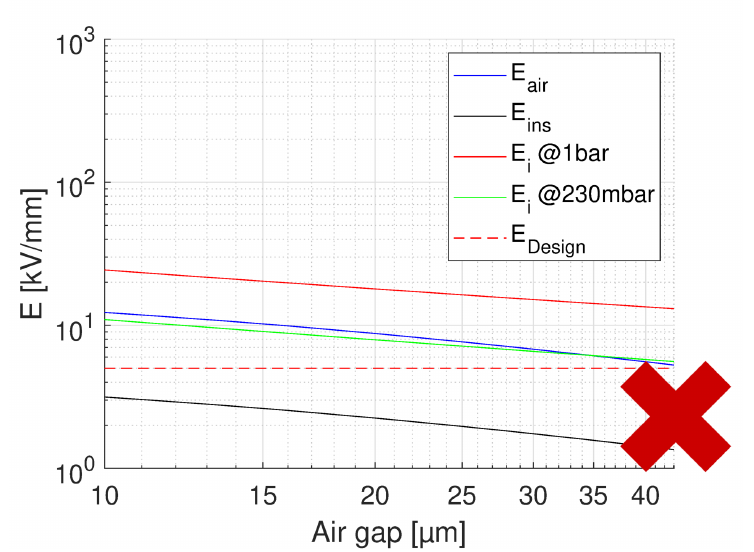
Figure 10. Feasibility plot for the optimum design of turn insulation, with the highest design field (5 kV/mm), and thinnest insulation (H1 = 43 µ m). Maximum voltage drop between turns 227 V (benign test conditions, Table 1). The x axis reports the air gap thickness. PD will be incepted in cavities of any size above 10 µ m at 230 mbar (35,000 ft).